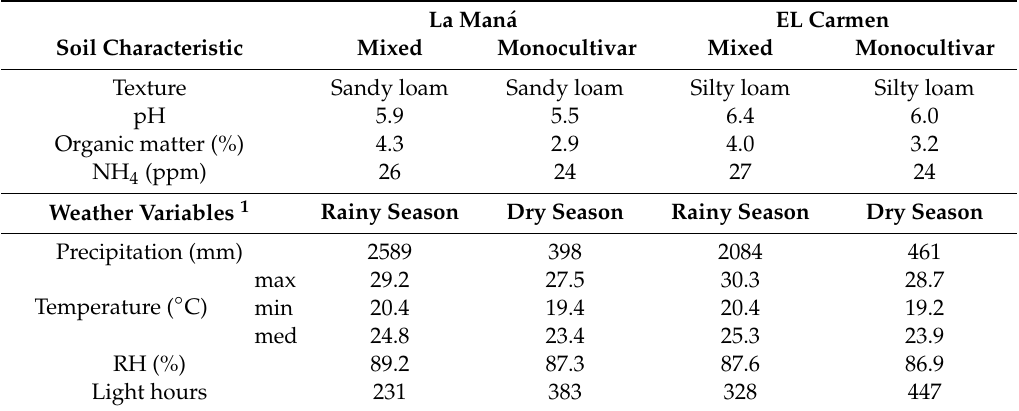
Table 1. Soil and weather characteristics of both sites and agricultural systems studied during